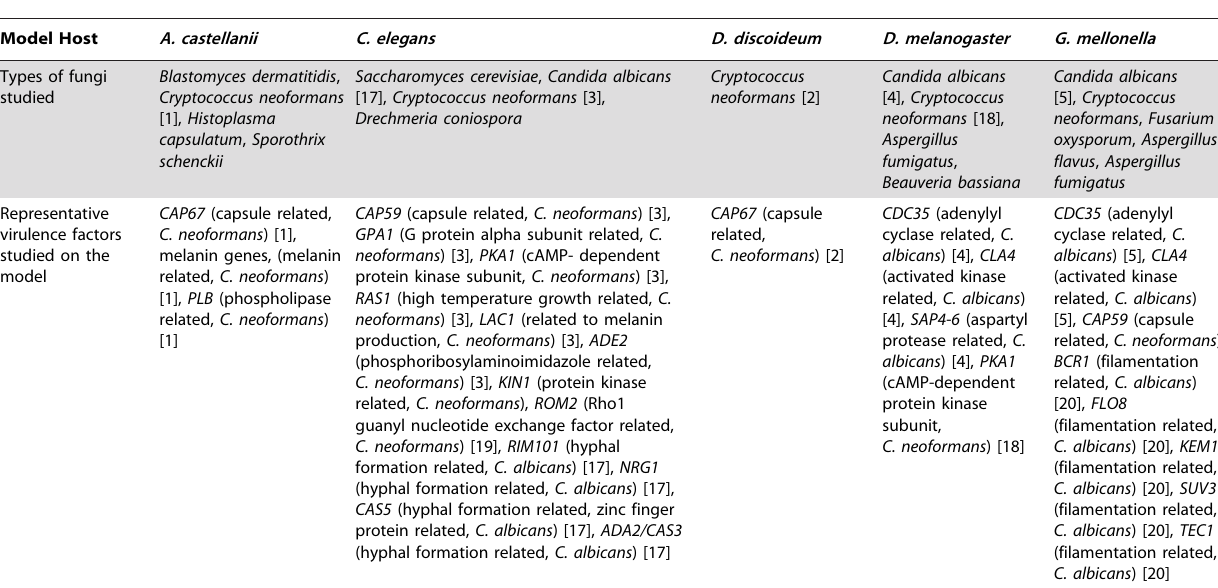
Table 1. Summary of findings generated by using the invertebrate infection models.